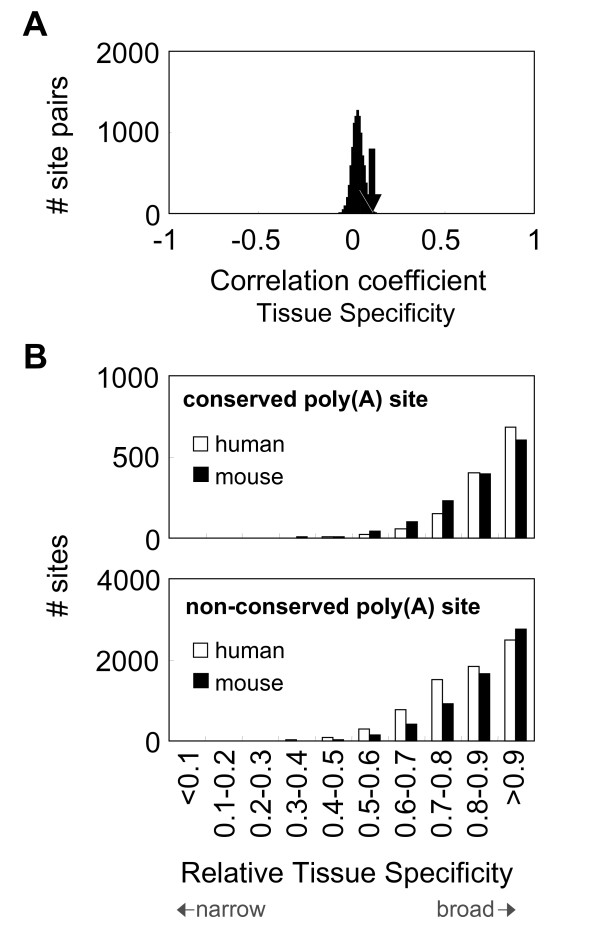
Relative tissue-specificity of conserved and non-conserved polyadenylation sites. (A) Distribution of 10,000 control correlation coefficients each computed from 1000 random pairs of non-conserved sites from orthologous human and mouse genes. Arrow indicates the correlation coefficient observed for pairs of conserved sites (r = 0.10). (B) Distribution of relative tissue-specificities in conserved and non-conserved polyadenylation sites. Number of sites in human (white) and mouse (black) is plotted against relative tissue specificity.